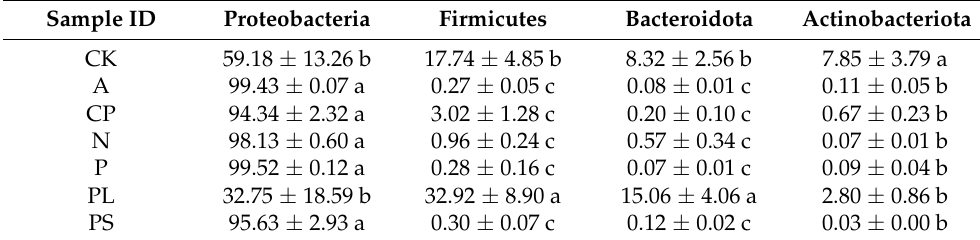
Table 2. The relative abundance of the top four phyla.